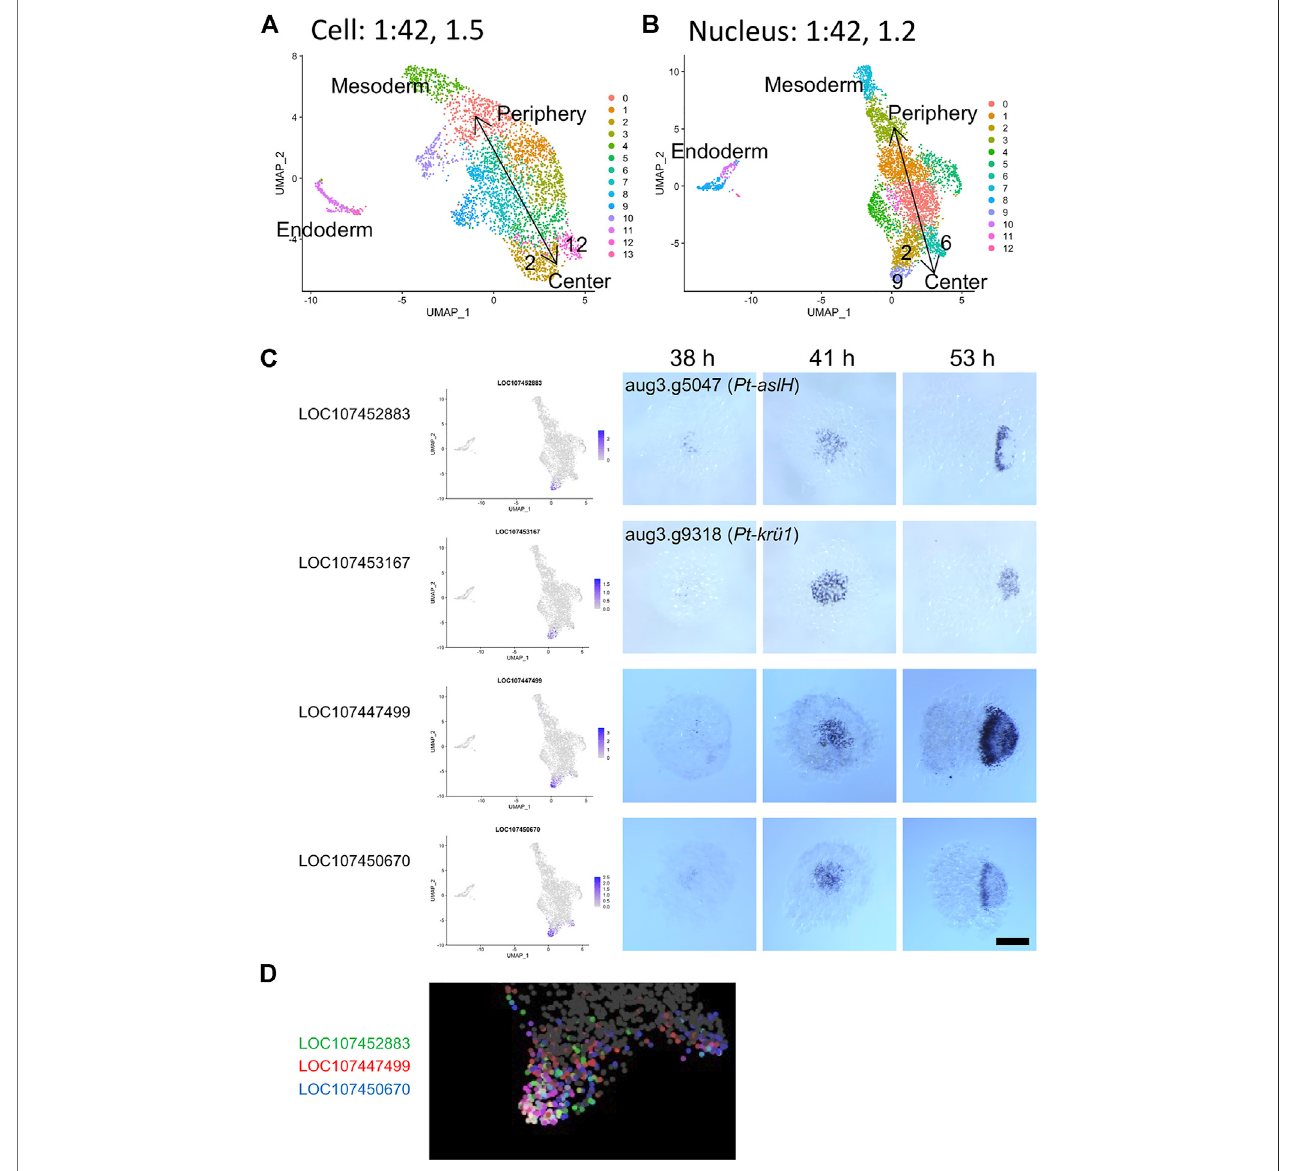
FIGURE 7 | Detection of a dynamically emerging cell state using single-nucleus transcriptomics. (A,B) The UMAP plots of 3,621 cells (A) and 4,720 nuclei (B) , showing clusters generated from the second single-cell (A) and the single-nucleus (B) transcriptome data. The clustering was performed using 42 PCs and with resolution parameters of 1.5 (A) and 1.2 (B) . Annotations of the germ layers and the reconstructed orientation of the germ disc are indicated. (C) Expression of cluster 9markergenesidenti fi edinthesingle-nucleustranscriptomeanalysis.TheexpressionisvisualizedontheUMAPplot(left)andisdetected usingWISH.Thestained embryosareatlategerm-discstage(38 h,latestage5),thestartofgerm-disctogerm-bandtransitionstage(41 h,earlystage6),andearlygerm-bandstage(53 h,stage 7). Embryos shown in the right panels (53 h) are oriented anterior to the left. Scale Bar = 200 μ m. The images of embryos stained for Pt-aslH and Pt-krü1 transcripts are from Akiyama-Oda and Oda (2020) (CCBY4.0). (D) Expression of three cluster 9 marker genes visualized in three colors on the UMAP plot. The cluster 9 region is enlarged.